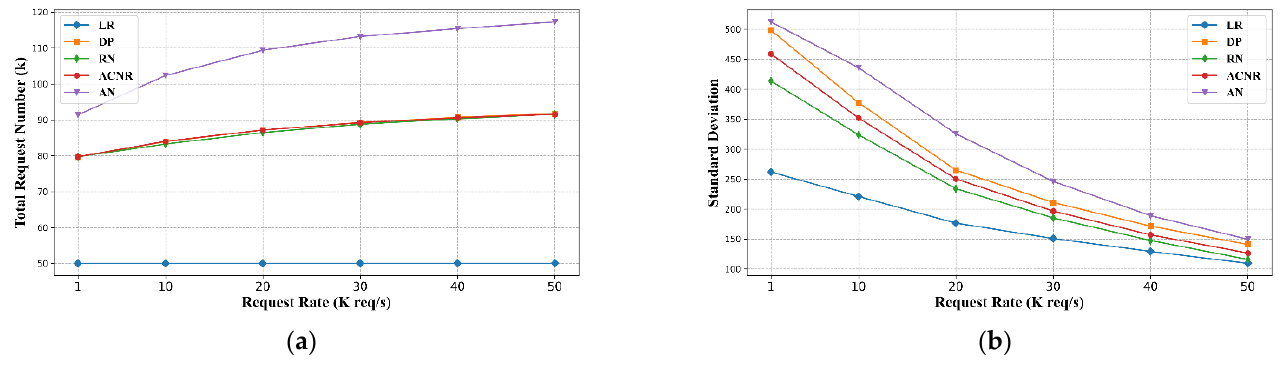
Figure 6. Load metrics comparison for each strategy with different name resolution request rates. ( a ) Total request number with different name resolution request rates. ( b ) Standard deviation of the loads on name resolution nodes comparison with different name resolution request rates.